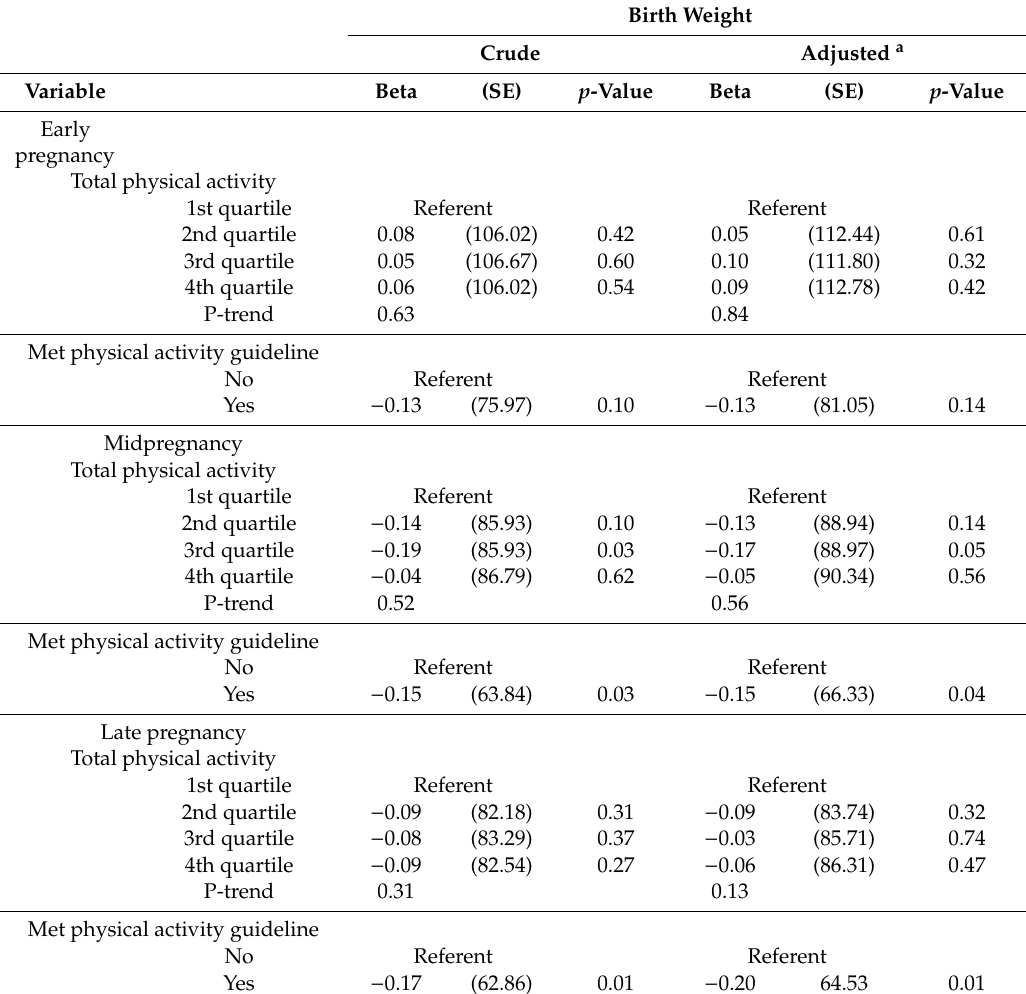
Table 5. Beta coe ffi cients and standard errors (SE) for the association of physical activity during pregnancy on birth weight (BW) in multinomial regression